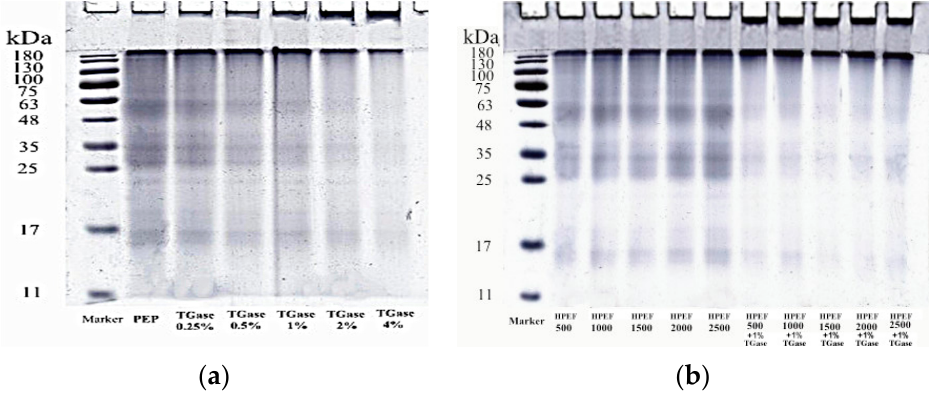
Figure 3. The effects of HPEF (500, 1000, 1500, 2000, and 2500 V/cm) addition, TGase (0.25, 0.5, 1, 2, and 4%), and compound treatment (HPEF-500, 1000, 1500, 2000, 2500 V/cm; 1% TGase) on the molecular weight of PEP. ( a ): The effects of TGase (0.25, 0.5, 1, 2, and 4%); ( b ): The effects of HPEF (500, 1000, 1500, 2000, and 2500 V/cm) addition and compound treatment (HPEF-500, 1000, 1500, 2000, 2500 V/cm; 1% TGase).